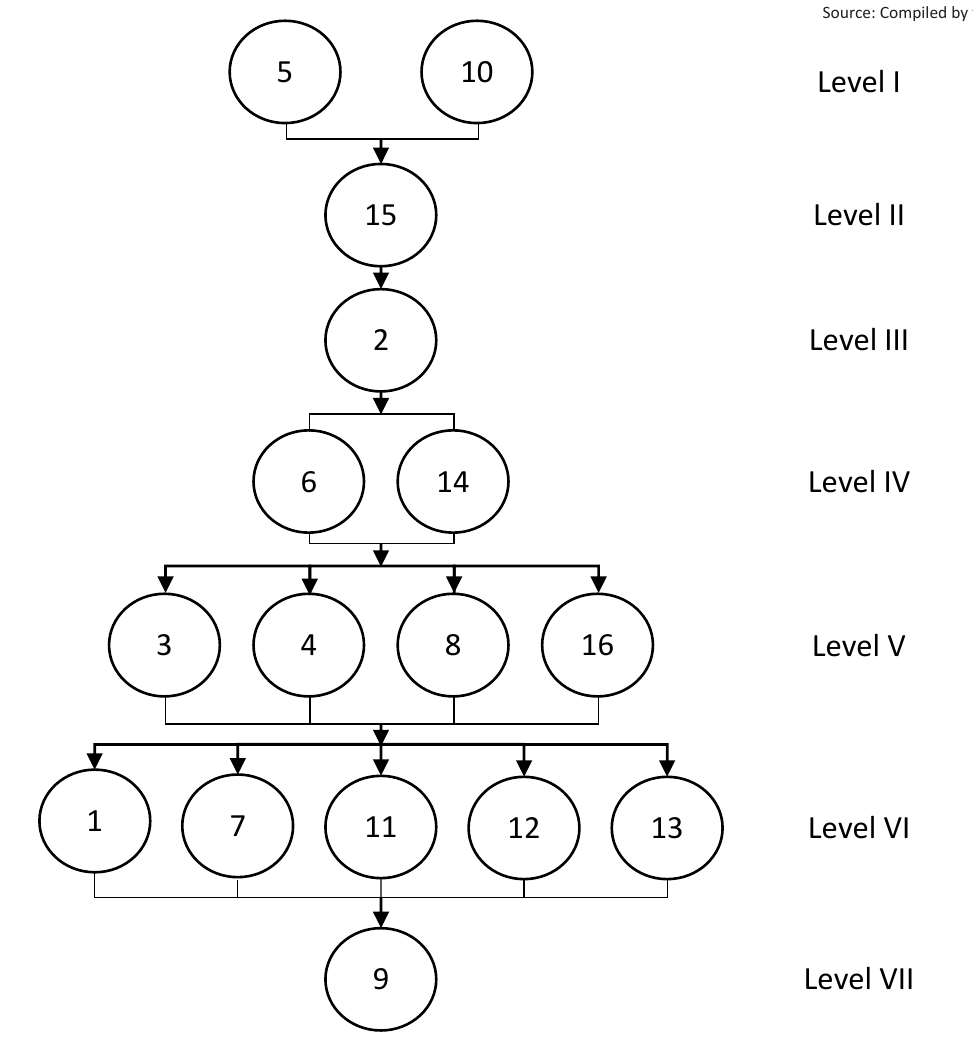
Figure 3. Model of hierarchy of the factors of influence on energy security of the